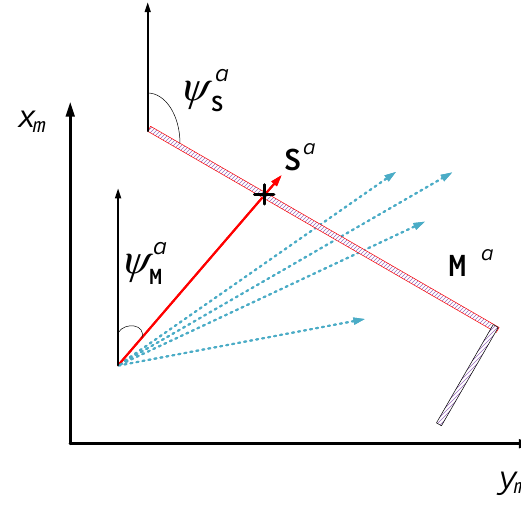
Figure 9. The active ray and active